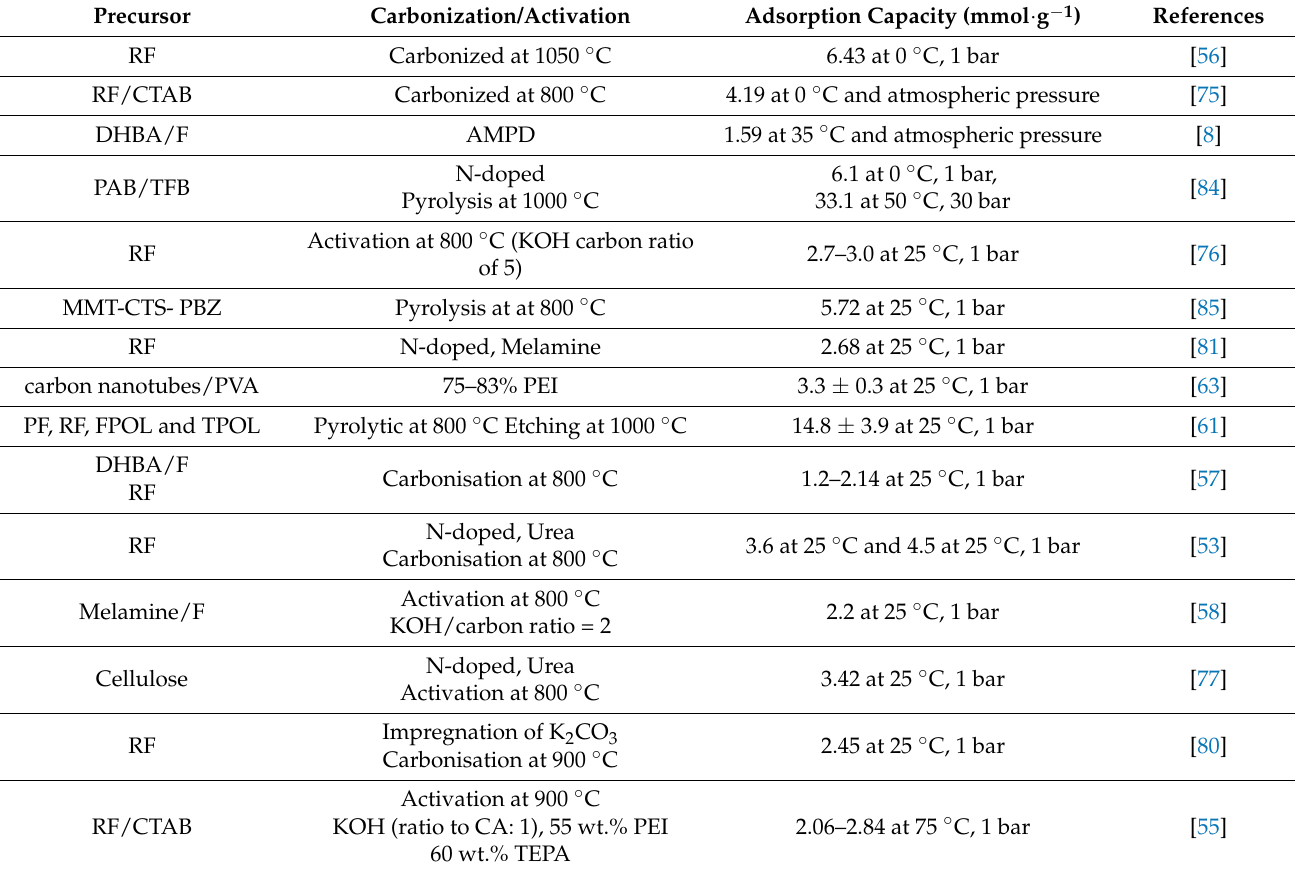
Table 2. CO 2 capture by organic